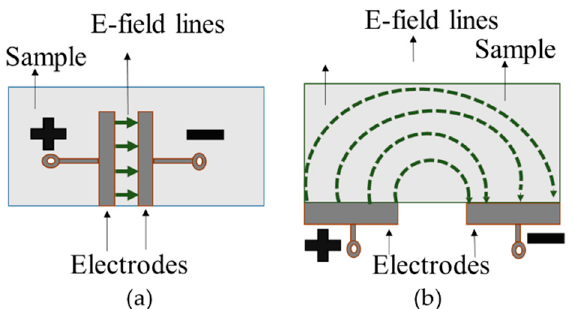
field zone suitable for measuring pure dielectric samples. The parallel combination of the interdigital structure provides a high e-field zone, which detects the proximity of testing MUTs even with a minute gap through reflection. Adjusting the gap between the fingers and electrodes indicates a higher interaction between the testing sample and the field [22,30].